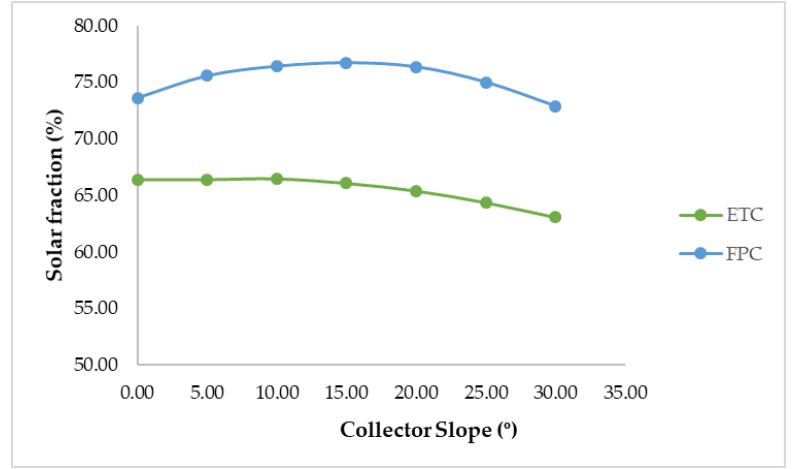
Figure 7. Optimum slope of solar collectors.